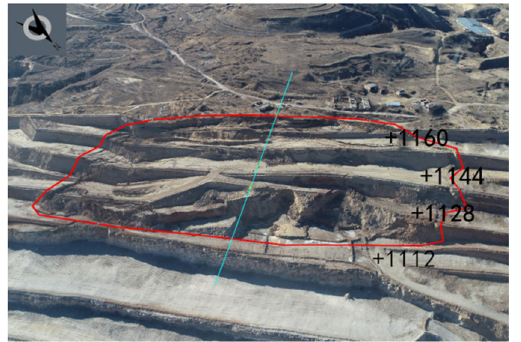
Fig. 1 Simplified model of profiles of typical strata in Weijiamao open-pit mine